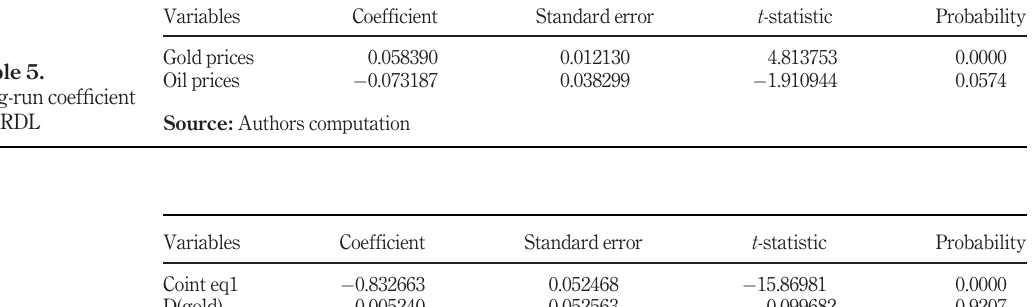
Table 6. Short-run error correction of ARDL